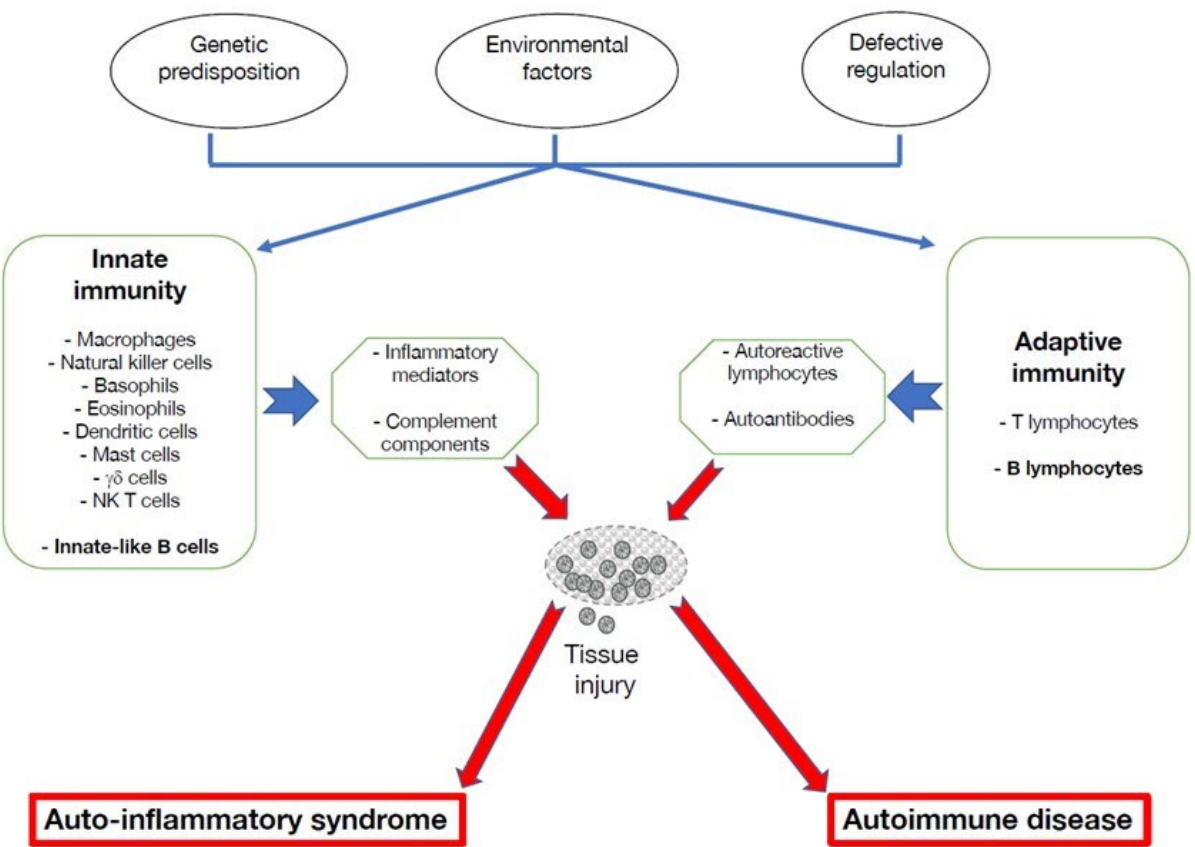
Figure 5. Genetic predisposition, environmental factors, and defective immune regulation underlie initiation of both autoimmune diseases and auto ‐ inflammatory syndromes. The BLK and CD40 loci are known to be associated with AIDs, such as lupus, arthritis and Crohn’s disease, as well as AIFS, such as Kawazaki syndrome. Environmental triggers have been documented in several AID and AIFS. Defects in development or functions of cells of both innate and adaptive immunity may lead to abnormal functionalities in these cells and altered or hyperactive immune responses [56,70]. These various factors, in isolation or in combination, can result in tissue injury. By virtue of their roles in both the innate and adaptive immune systems, B cells are at the crossroads of autoimmune diseases and auto ‐ inflammatory syndromes.